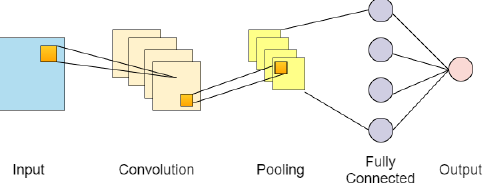
Figure 3. Fully convolutional neural network architecture on time series classification